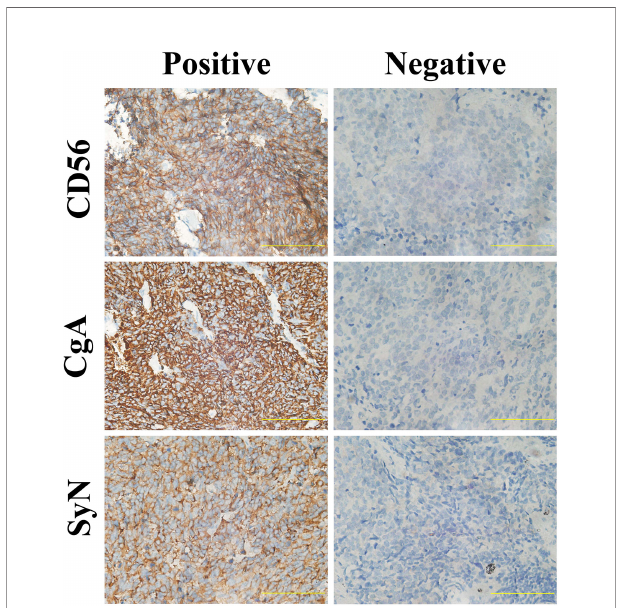
FIGURE 4 | Representative Images of Immunohistochemical Staining for Neuroendocrine Differentiation Markers of Primary Small Cell Lung Cancer Tumors. Scale bar: 100 m M. Cytoplasmic staining of tumor cells was considered positive for SyN and CgA, and tumors with membrane staining were considered positive for CD56. SyN, Synaptophysin; CgA, Chromogranin